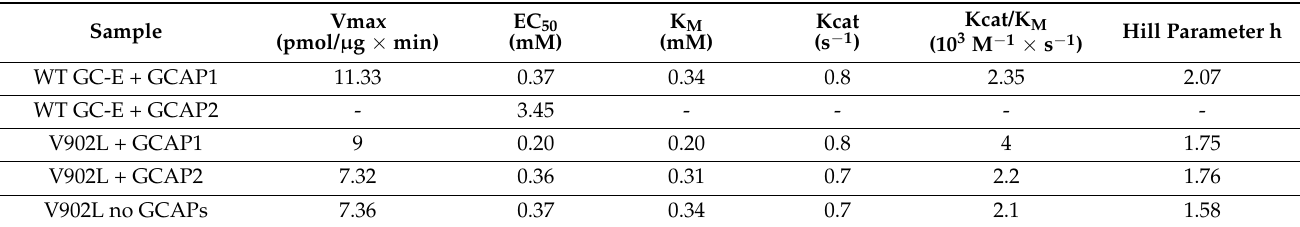
Table 1. Catalytic parameters of WT GC-E and